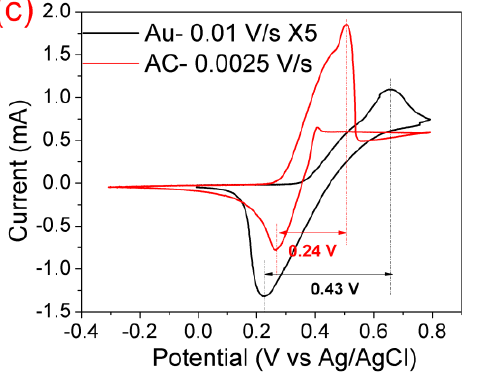
Figure 3. Cyclic voltammograms (CVs) of 0.01 M I 2 –1.5 M NaI catholyte on various carbonaceous electrodes: ( a ) Glassy carbon (GC) foam and carbon paper electrode, ( b ) graphite felt GFD4.6 and